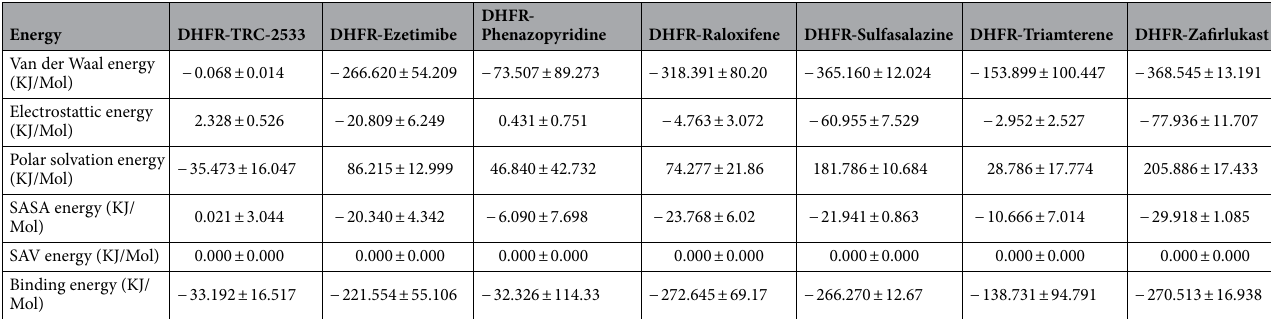
Table 4. The Van der Waals, electrostatic, polar solvation, SASA, SAV, and binding energies of the DHFR- TRC-2533, DHFR-Ezetimibe, DHFR-Phenazopyridine, DHFR-Raloxifene, DHFR-Sulfasalazine, DHFR- Triamterene, DHFR- Zafirlukast complexes (kJ/mol), calculated by the MMPBSA method.